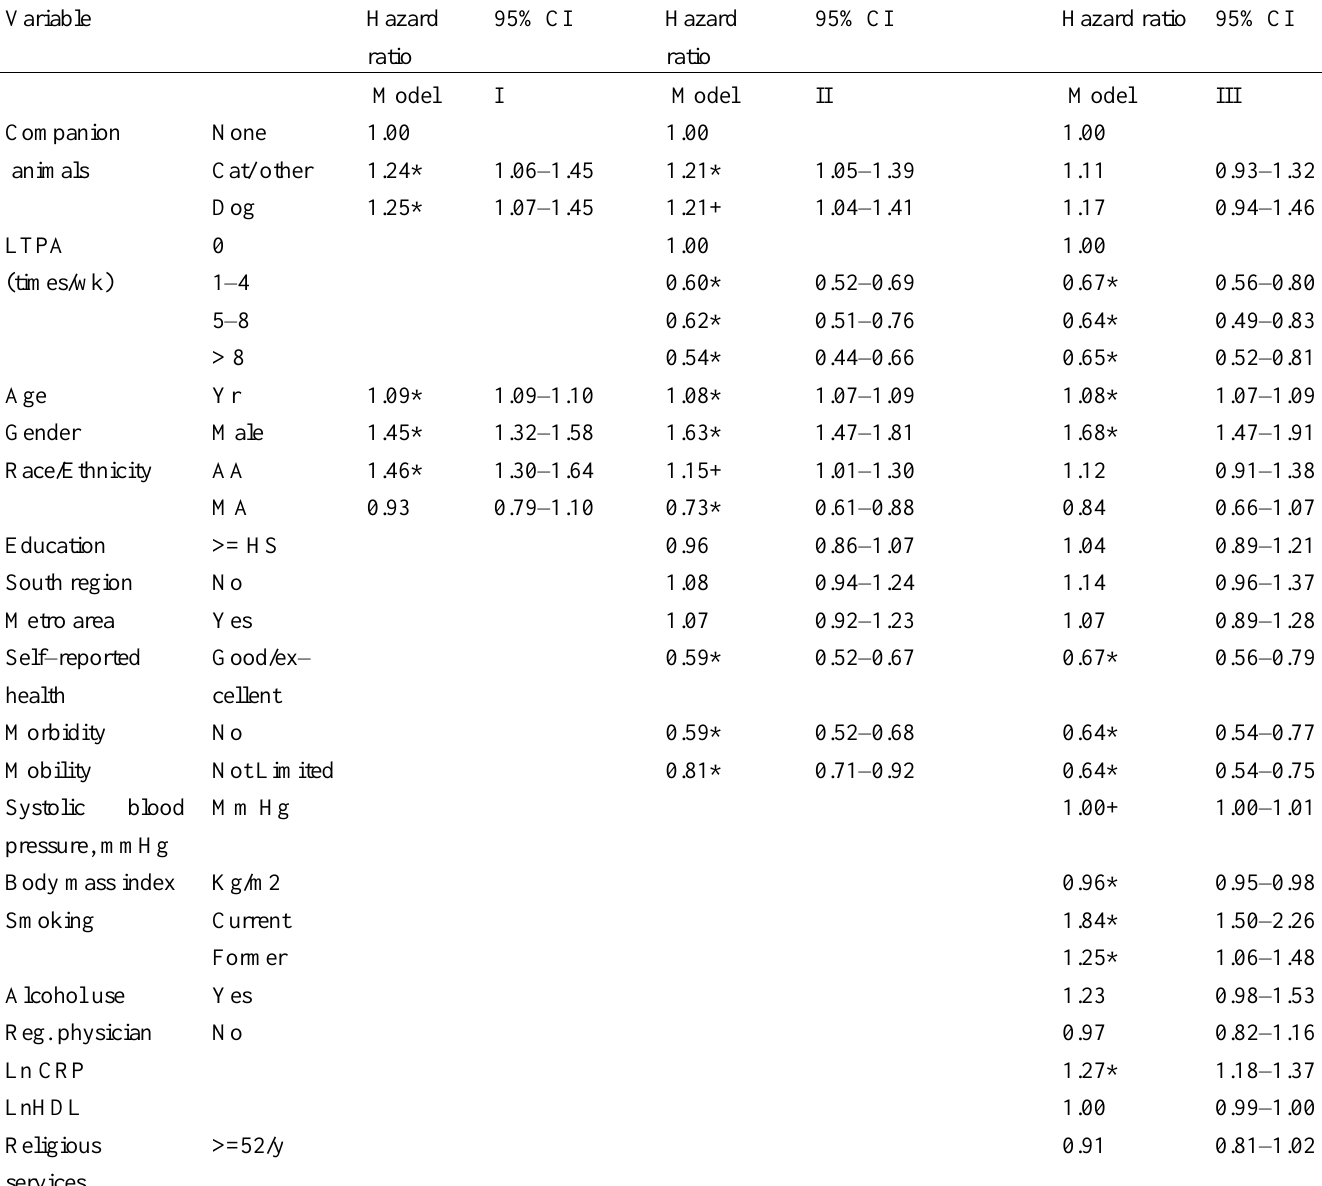
Table 3. Adjusted hazards ratios (95% confidence intervals) of living with companion animals for mortality from all causes among persons aged 40 years and over in NHANES